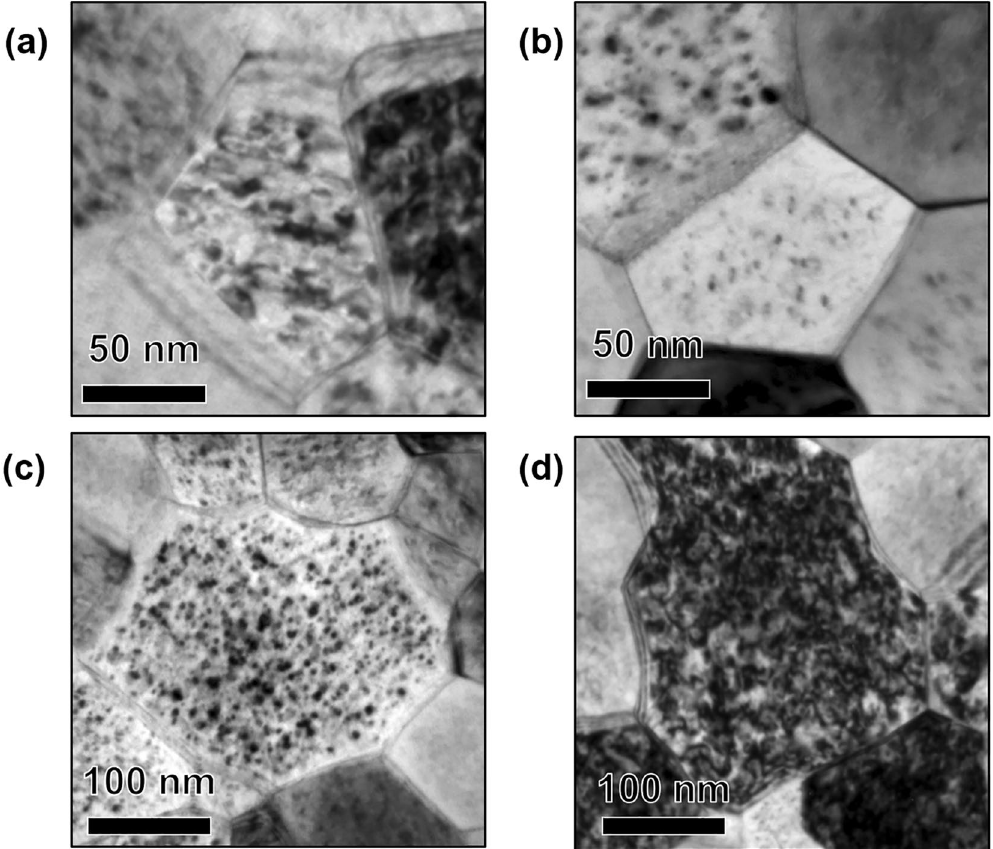
Figure 6. ( a ) and ( b ) Bright-field TEM image of irradiated nanocrystalline grains (approximately 80 nm average size) with loop denuded and non-denuded zones respectively. ( c ) and ( d ) Bright-field TEM image of irradiated ultra-fine grains (approximately 220 nm average size) with loop denuded and non-denuded zones respectively. Images taken at the end dose (2.87 × 10 21 ion.m − 2